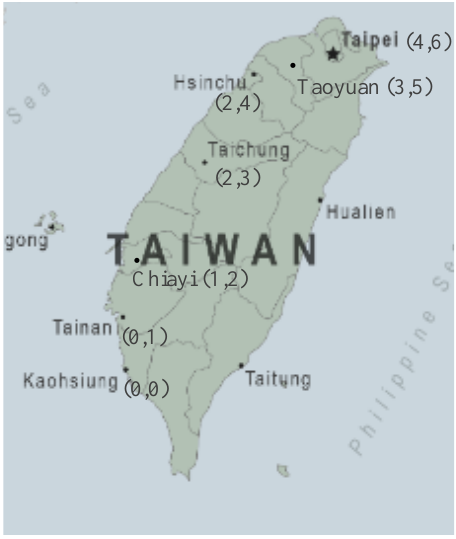
Figure 5. Coordinates of seven cities in Taiwan.